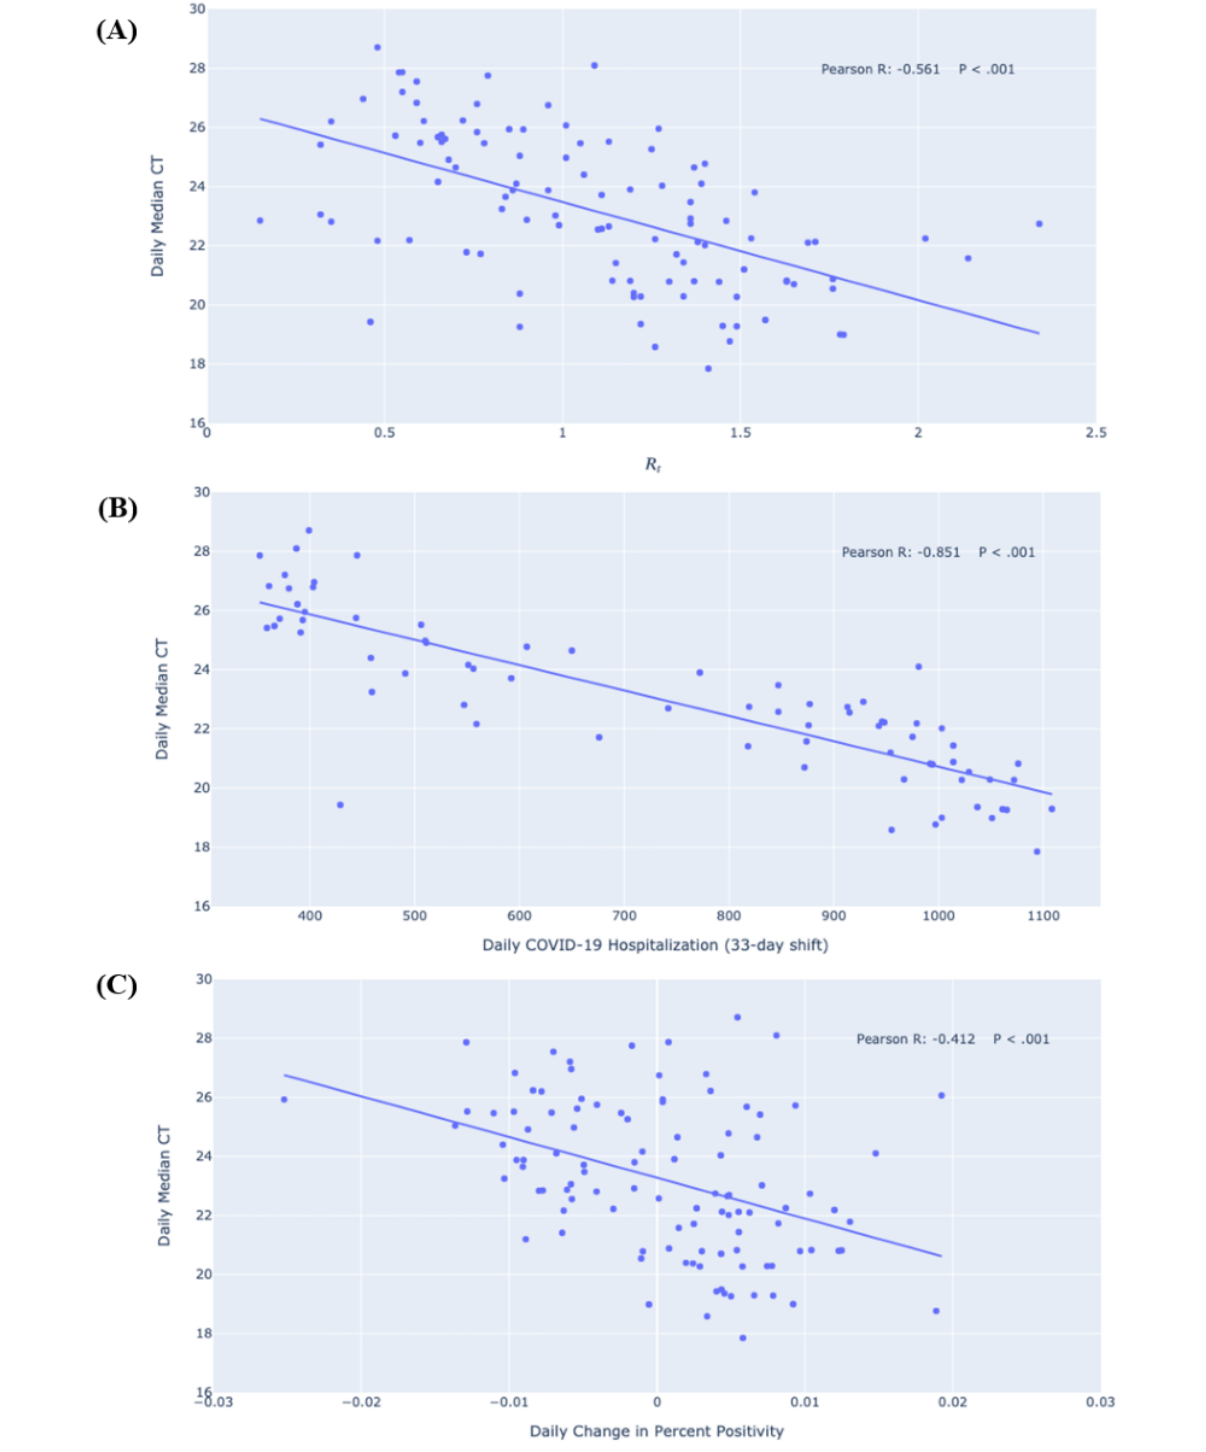
Figure 2. Linear regressions and scatter plots of (A) daily median CT values for SARS-CoV-2–positive samples versus daily transmission rate SARS-CoV-2 R t , (B) daily numbers of hospitalized individuals with COVID-19, and (C) daily changes in percent positivity for SARS-CoV-2 detection in the greater El Paso area between September 15, 2020, and January 11, 2021. CT: cycle threshold; R t : transmission